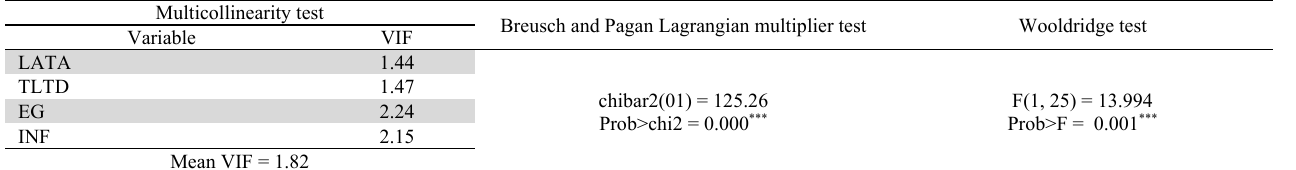
Results of testing research model